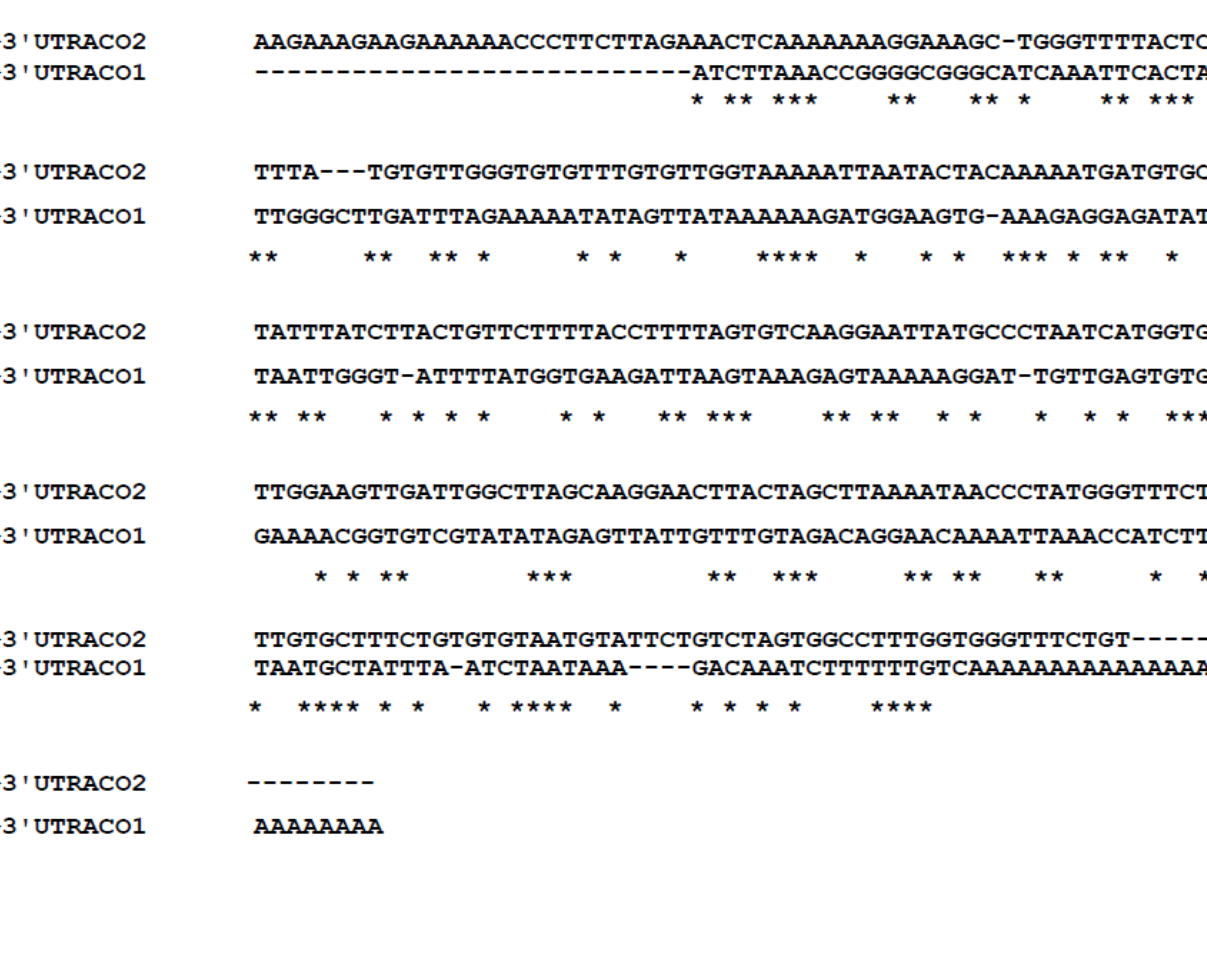
Figure 1. Sequence alignment of 3 ′ UTR region of ACO 1 and ACO 2 isolated from Malaysian Eksotika papaya [12]. The DNA sequences of both ACO show high diversity. Asterisks ( * ) indicate the similarity of both ACO